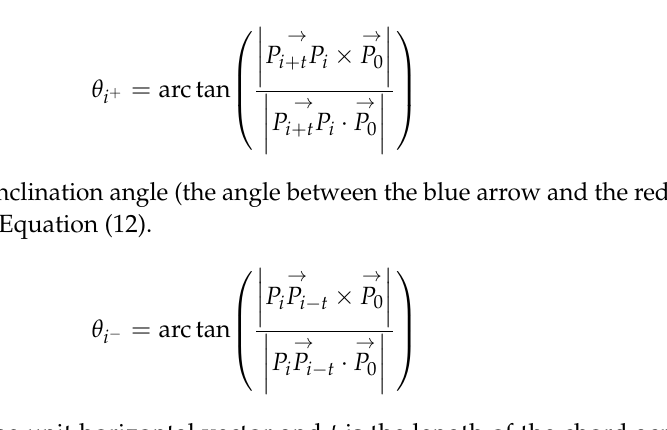
Figure 7. Diagram of the front and back chord inclination angles. The front chord inclination angle (the angle between the green arrow and the red arrow) was calculated using Equation (11).